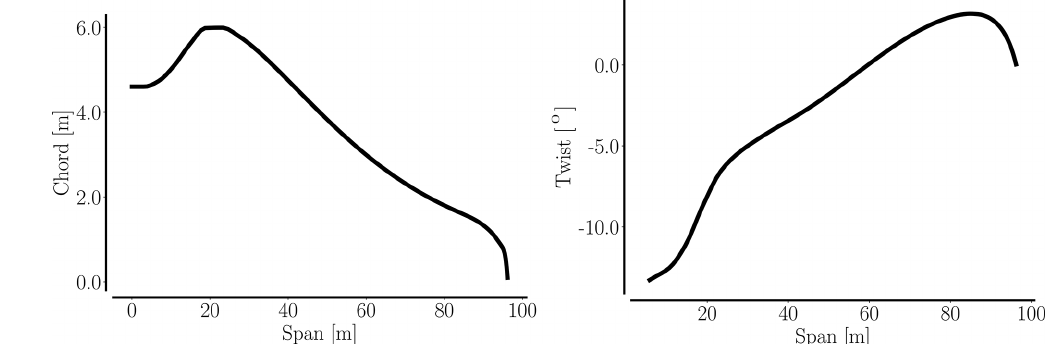
Figure 2. The IEA 10MW wind turbine (baseline) planform.